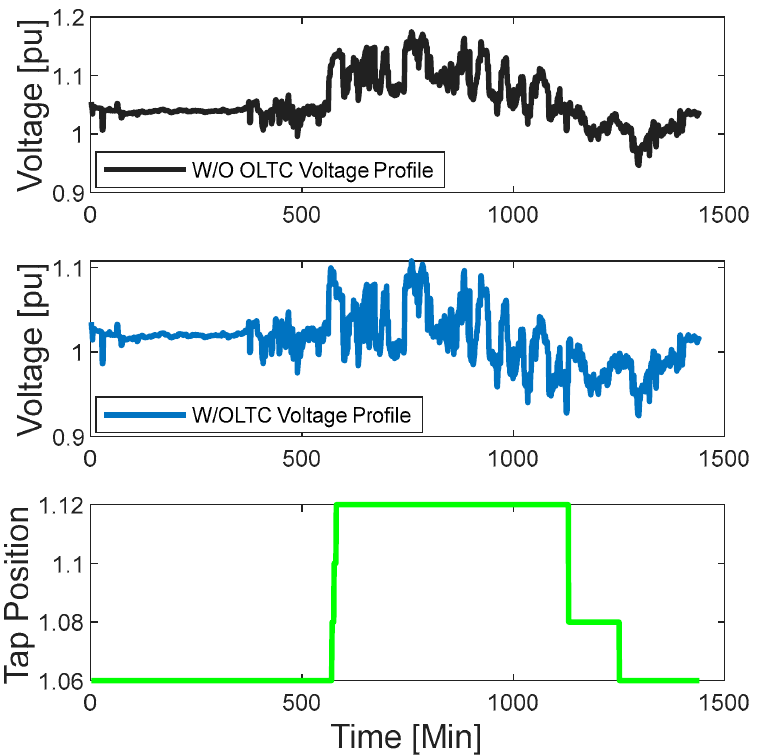
Figure 8. Voltage profile at the last customer (at Feeder-3) and tap position (green line) at 100% PV penetration level.